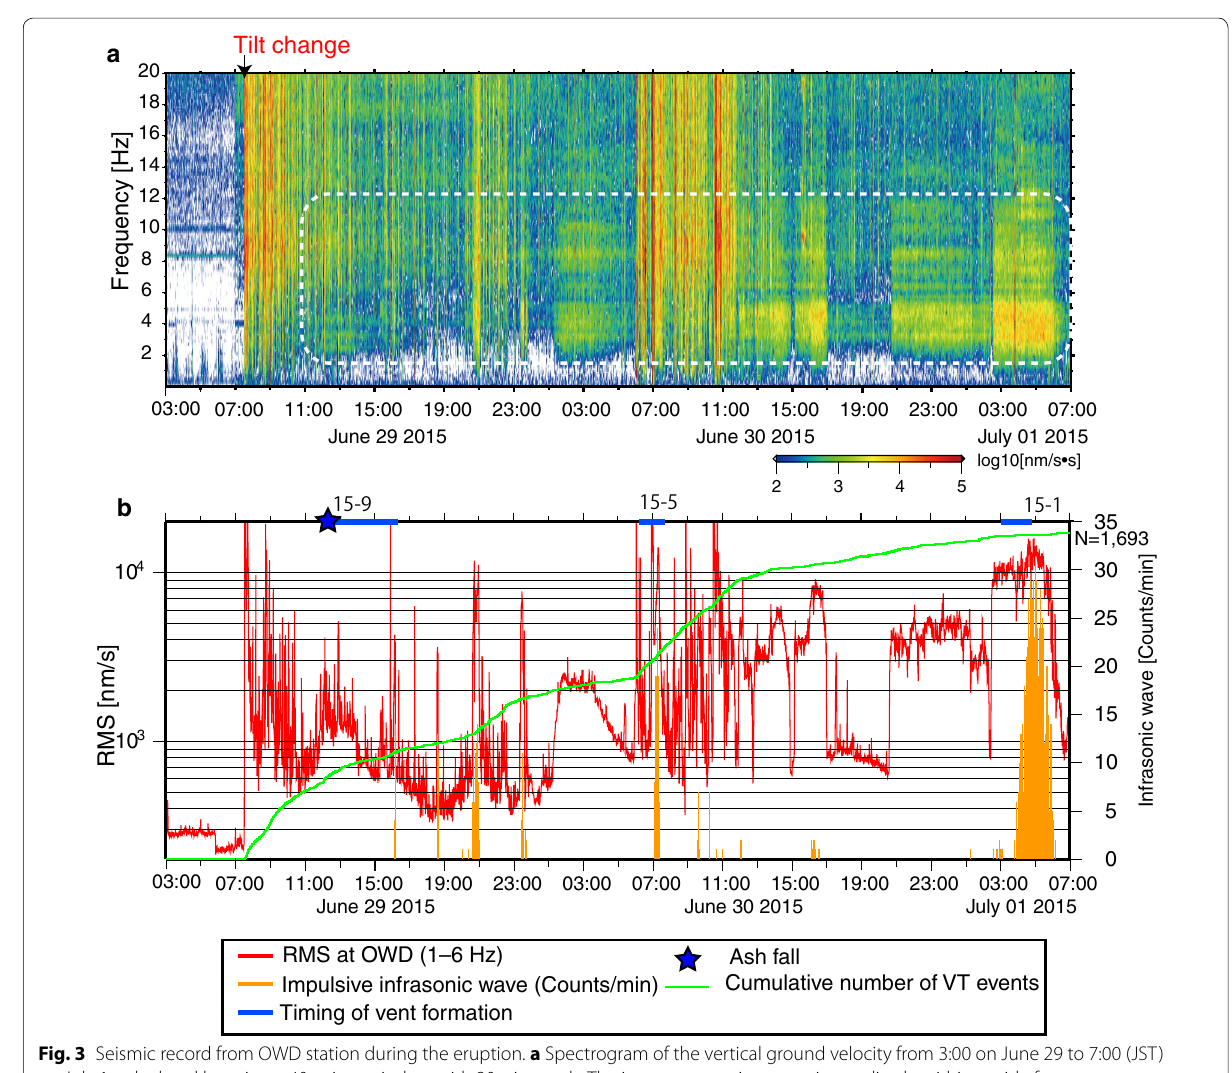
Fig. 3 Seismic record from OWD station during the eruption. a Spectrogram of the vertical ground velocity from 3:00 on June 29 to 7:00 (JST) on July 1, calculated by using a 40-s time window with 20-s intervals. The instantaneous increases in amplitude within a wide frequency range correspond to signals from VT earthquakes, whereas the continuous signal within the region framed by the box is due to the volcanic tremor. b Root-mean-square amplitude of the filtered vertical ground velocity (1–6 Hz) using a 1-min time window (red line). In order to mitigate contamina- tion by VT earthquakes, signals from earthquakes were deleted using an auto-detection algorithm based on the short-term average/long-term average ratio. The vertical orange lines and horizontal blue bars indicate impulsive infrasonic wave counts per minute and the vent formation times (Mannen et al. 2015), respectively. The numbers on the blue bars show the index number of vents defined in Mannen et al. (2015). The green line indicates the cumulative number of VT events that occurred during this